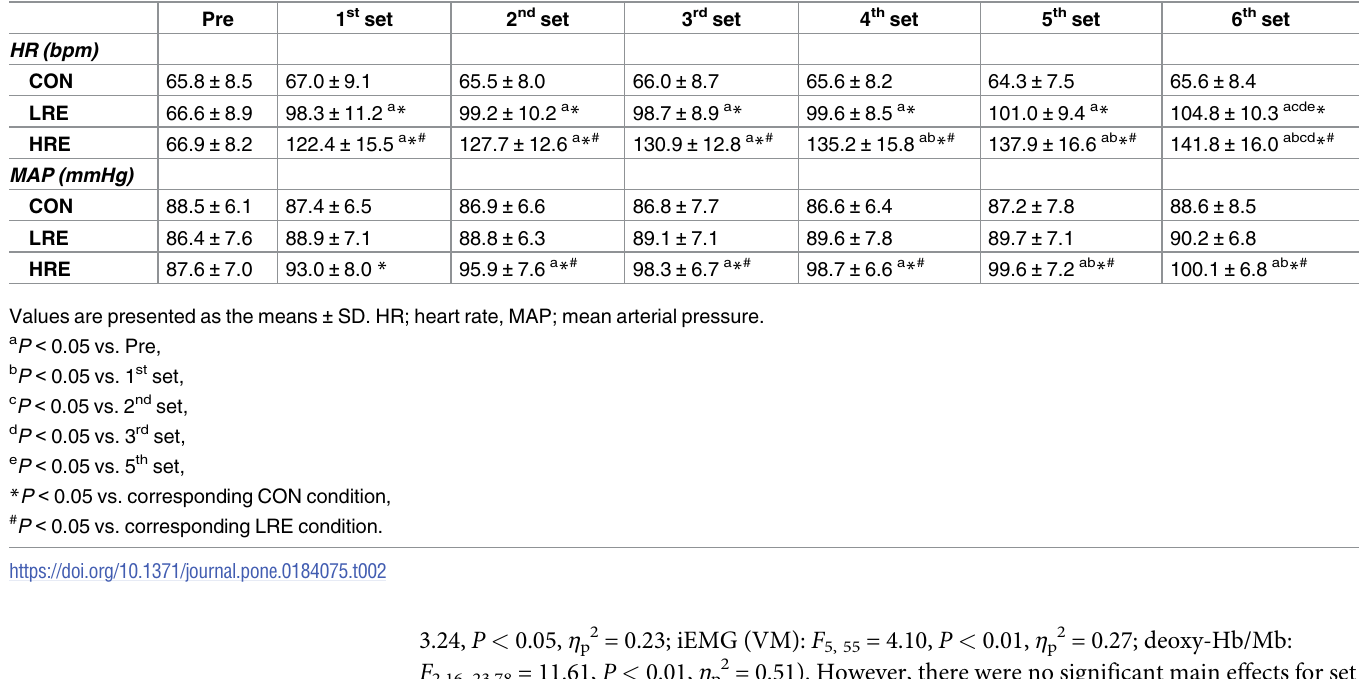
Table 2. Changes in cardiovascular responses during exercise.